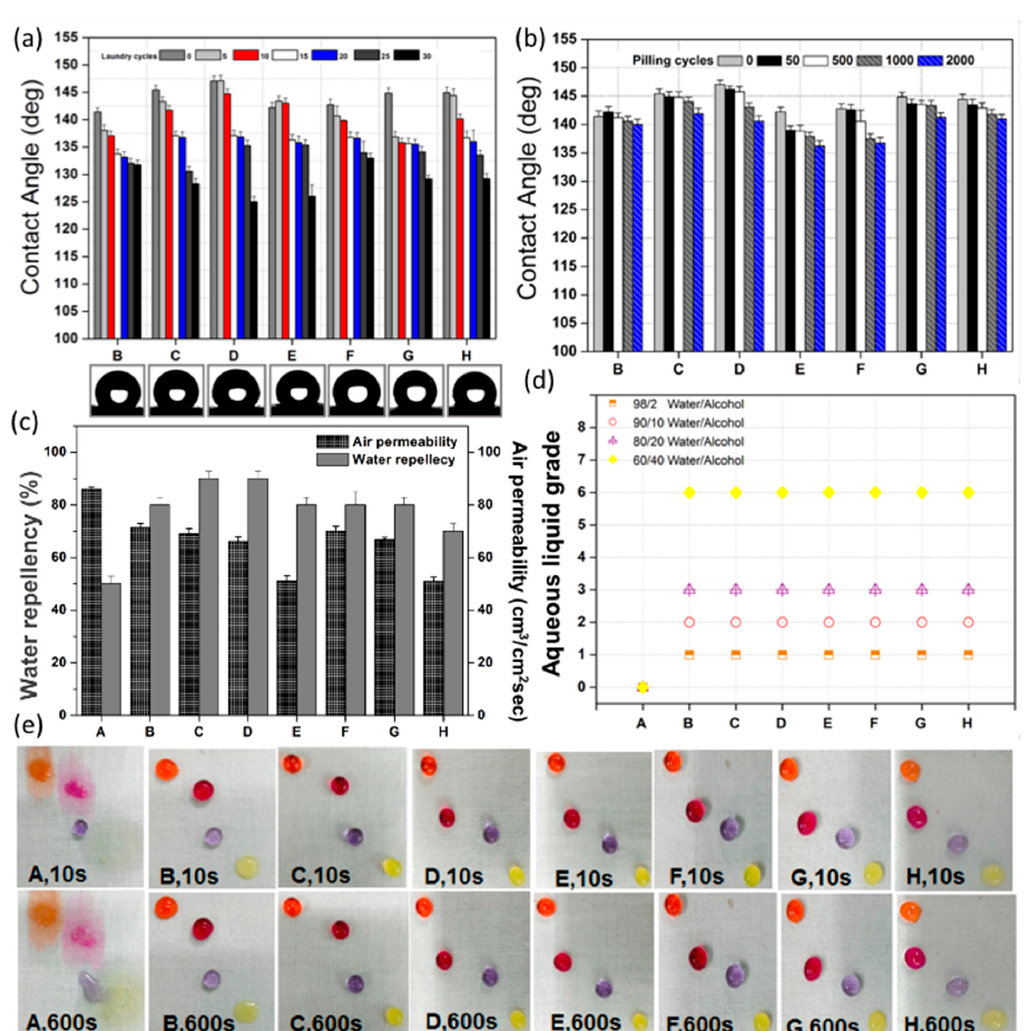
Figure 3. Protection of the as-coated cotton fabrics against water and aqueous liquids: ( a ) WCA after laundering (Photos: WCA profiles); ( b ) WCA after pilling; ( c ) Water repellency and air permeability; ( d ) Aqueous liquid repellency; ( e ) Photos of droplets of aquous liquids on the surface of cotton fabrics (Water/alcohol ratios: Organge 98/2; Pink 90/10; Purple 80/20; Yellow 60/40).